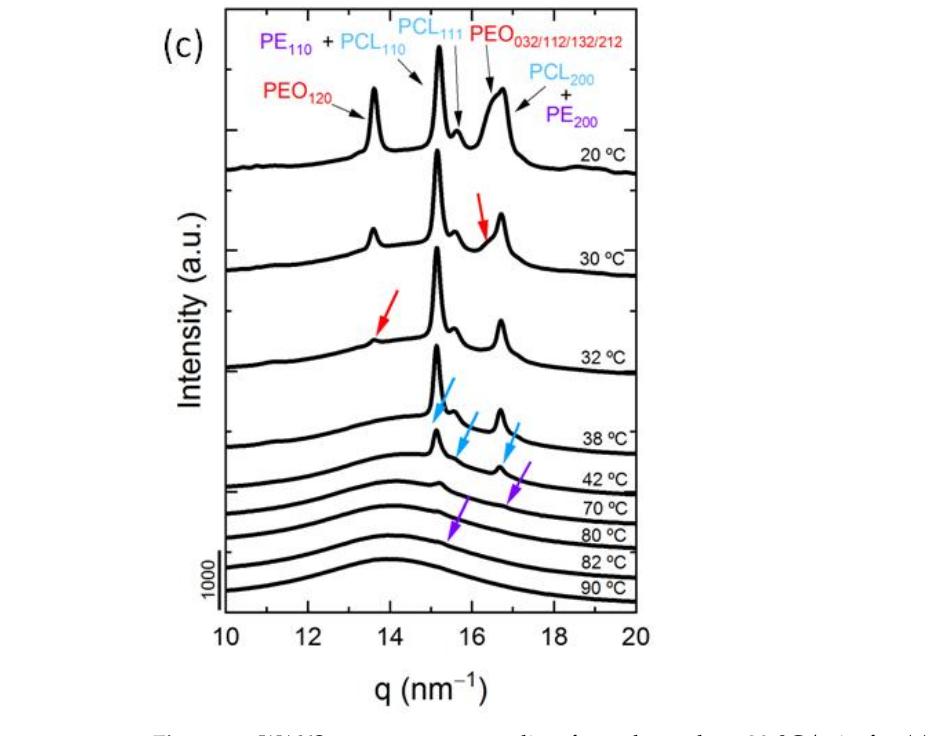
Figure 6. Normalized WAXS intensities as a function of temperature calculated from WAXS data represented in Figure 5 for ( a ) PE 7.1 (PE 110 (15.4 nm − 1 )), ( b ) PE 327.1 -b- PEO 6815.1 (PE 110 (15.4 nm − 1 ) and PEO 120 (13.8 nm − 1 )), and ( c ) PE 22 7.1 -b- PEO 4615.1 -b- PCL 3210.4 (PEO 120 (13.8 nm − 1 ), PE 110 (15.4 nm − 1 ) and